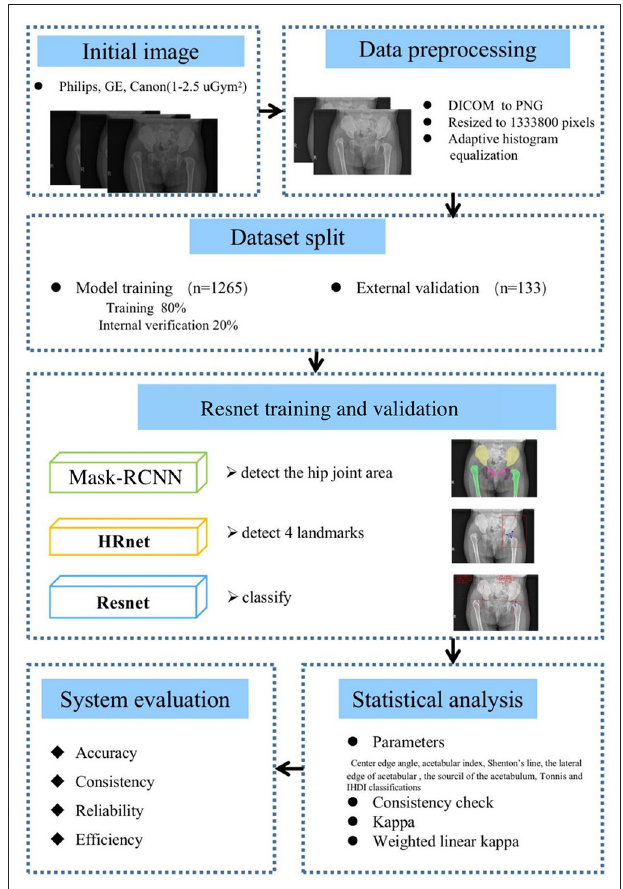
FIGURE 1 | Method and analysis pipeline. Images were acquired at the hip joint, and all images were image preprocessed. The data set was divided into a model training set and an external verification set, Mask-RCNN, high-resolution network (HRNet), Resnet were used to gradually realize hip joint segmentation, key point positioning, and parameter measurement. The performance of the artificial intelligence (AI) system and doctors of different years of experience were compared and the accuracy, consistency, reliability, and efficiency of the AI system was